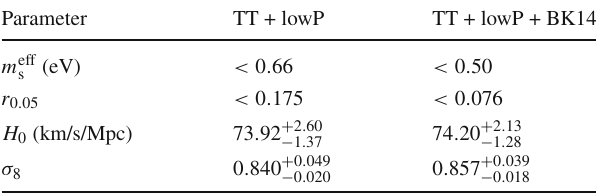
Table 4 Bounds on a cosmological parameters in the (cid:2) CDM + r 0 . 05 + m eff s model with N eff = 4 . 046, assuming complete thermalization of sterile neutrinos. Marginalized limits are given at 68% C.L. whereas upper limits are given at 95% C.L. Note that H 0 and σ 8 are derived parameters